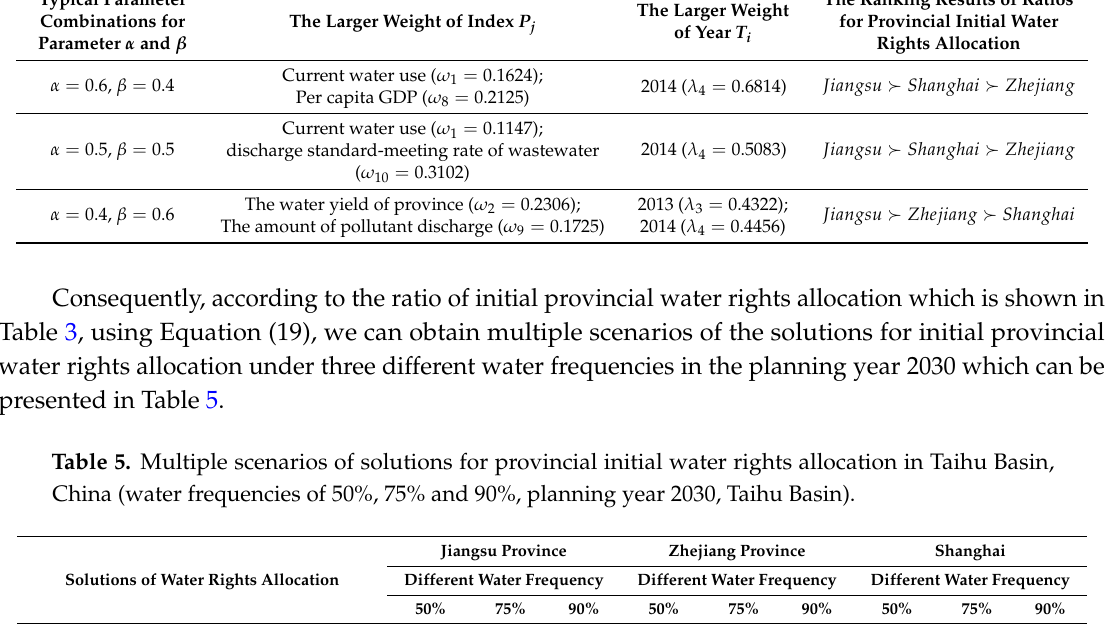
Table 4. Ranking results of initial provincial water rights allocation in Taihu Basin, China. Typical Parameter Combinations for